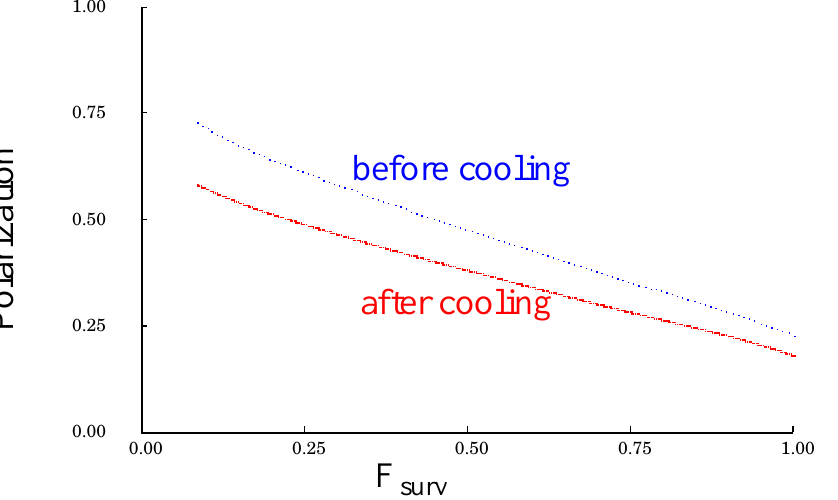
FIG. 21. (Color) Polarization vs fraction F surv of m ’s